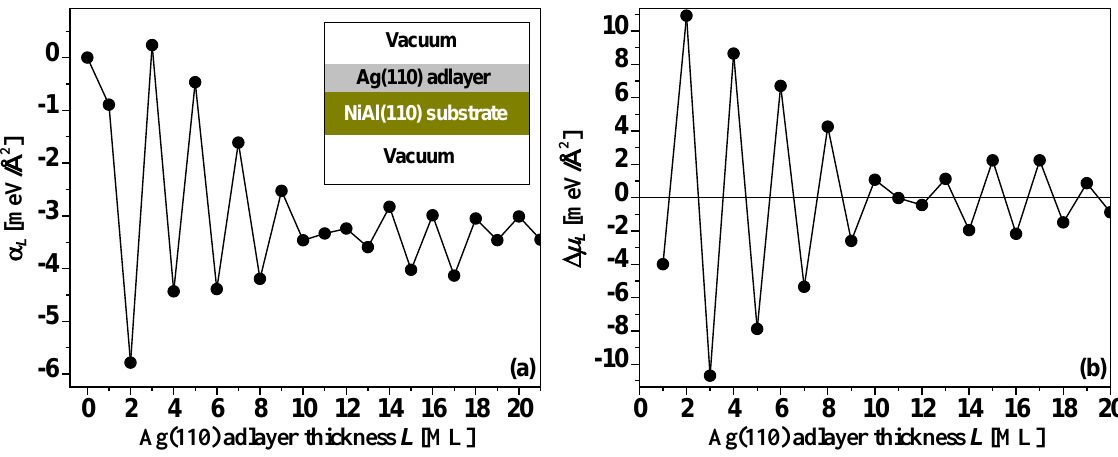
Figure 14. (a) Relative surface free energy α ∆µ from Equation (7), versus Ag(110) adlayer thickness L on NiAl(110) substrate from L DFT calculations. Adapted from [54] (Copyright Elsevier 2008).